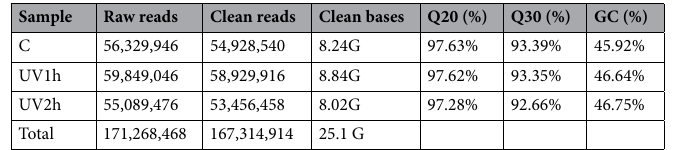
Table 1. Summary of sequences analysis for transcriptomes of Ostrinia furnacalis after UV-A